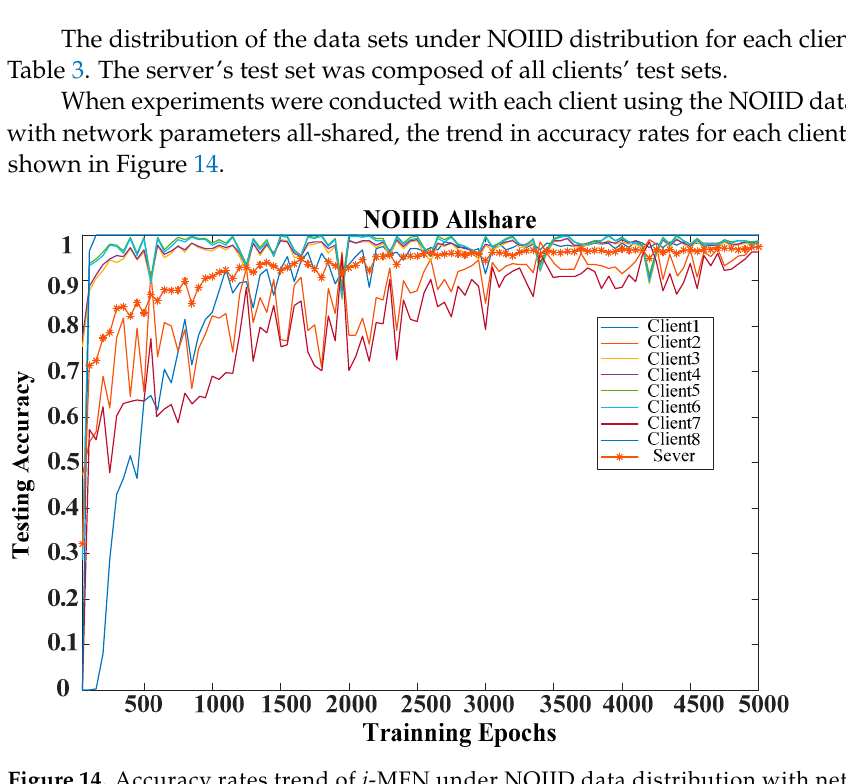
Figure 15. Accuracy rates trend under NOIID data distribution with network parameters isolated. From the experimental results, it can be seen that, for NOIID distributed data, local clients can only learn the features of their own data without parameters sharing. As a result, the local client network has little diagnostic ability when new fault types occur. So we can find that the diagnosis results are better in the Distributed-own case but worse in the Distributed-all case. Similarly, federated + average (Ave-FL) [21], in the case of NOIID data distribution, does not extract valid information well due to gradient interference, making the server unable to perform gradient fusion, thus reducing the diagnostic abil- ity. The i -MFN extracts some of the important network parameters for sharing and avoids the global sharing, effectively reducing the gradient interference from other cli- ents in the global sharing, thus greatly improving the overall network diagnostic capa- bility.